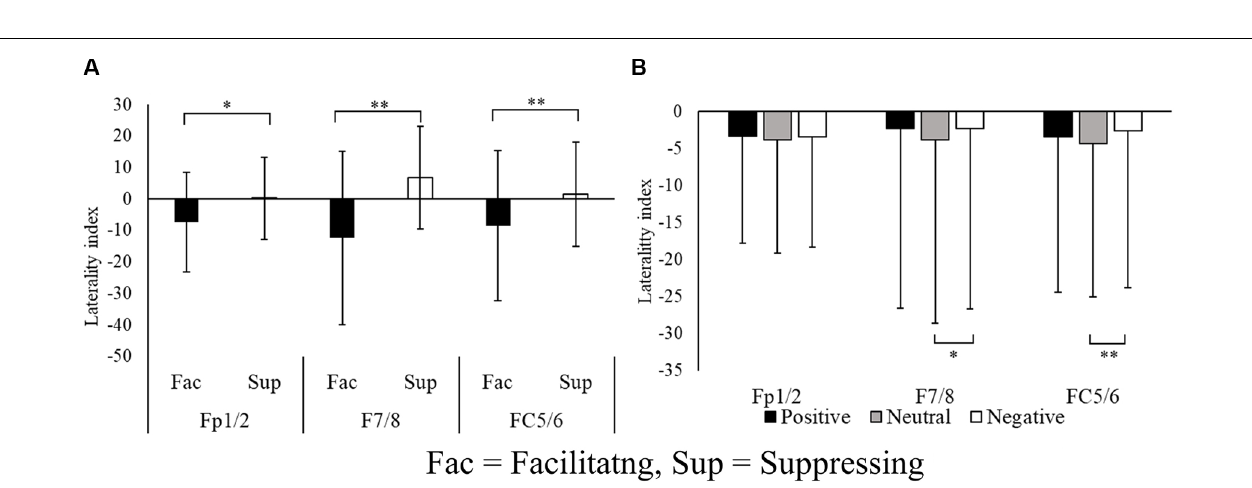
FIGURE 4 | Laterality indices of the pairs of electrode sites at the frontal region (A) and for each image stimulus (B) . ∗ p < 0.05, ∗∗ p <